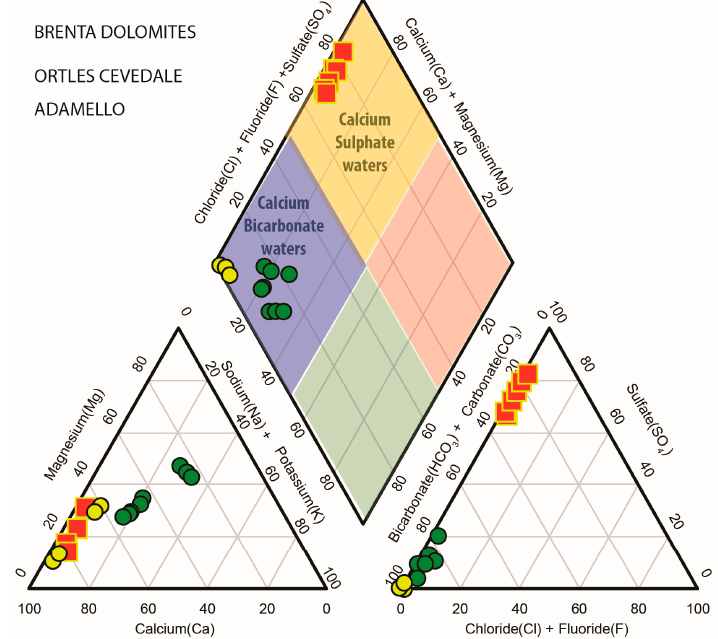
Figure 2. Piper classification diagram according to [60] demonstrating the hydrochemical facies of collected water in different mountain groups characterized by different lithologies.